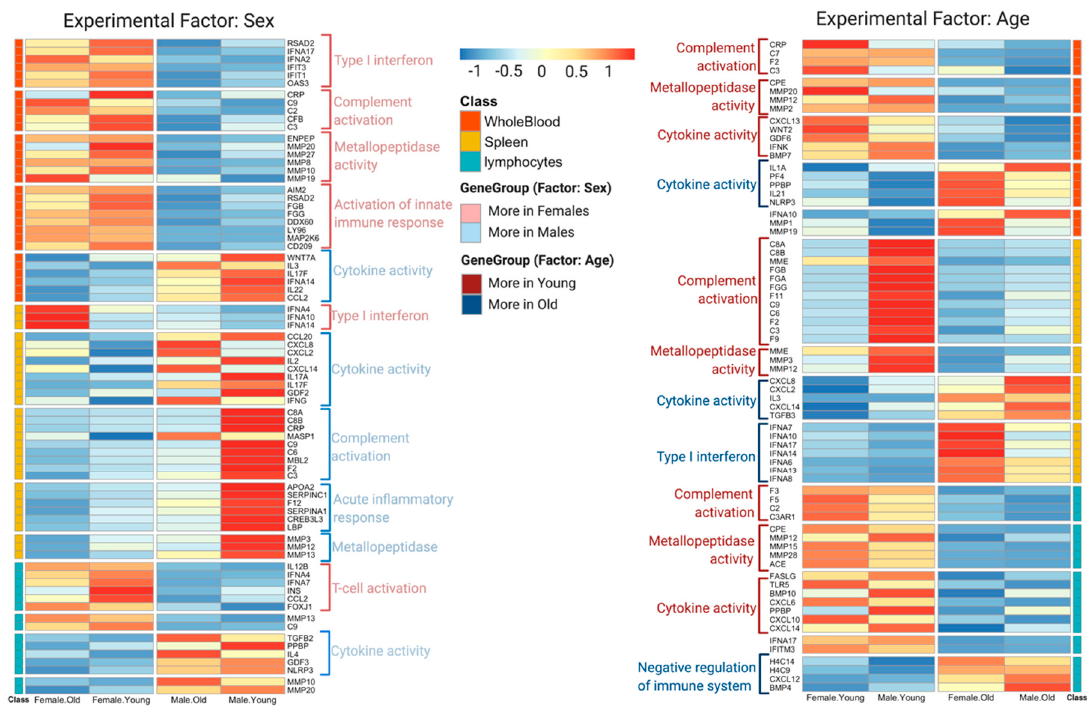
Figure 3 . Heatmap with significant sex ( left ) and age ( right ) expression differences for selected Figure 3. Heatmap with significant sex ( left ) and age ( right ) expression di ff erences for selected COVID-19 genes and pathways. Results for different immune system tissues and cell types and COVID-19 genes and pathways. Results for di ff erent immune system tissues and cell types and shown.